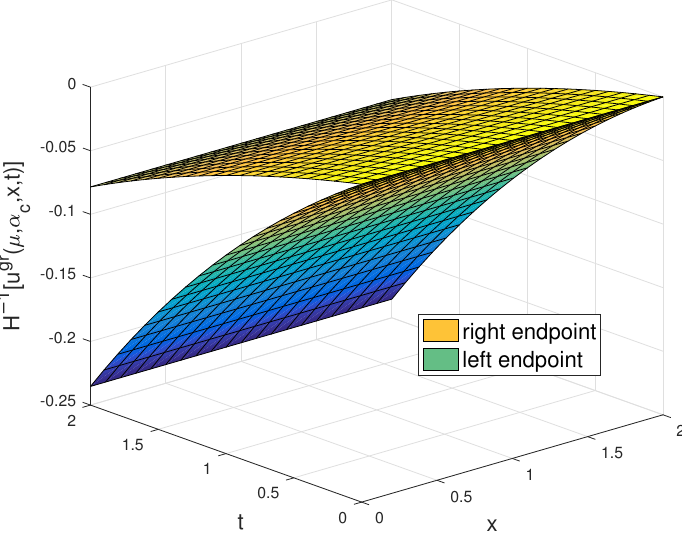
Figure 4. The fuzzy approximate solution (cid:101) u ( x , t ) of Example